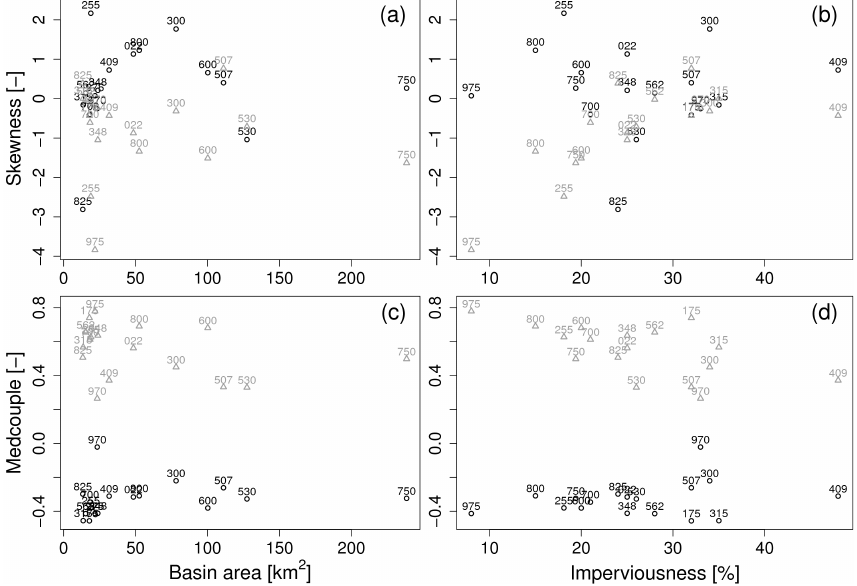
scale in time or (cid:49)q . Values on both x and y axes are plotted